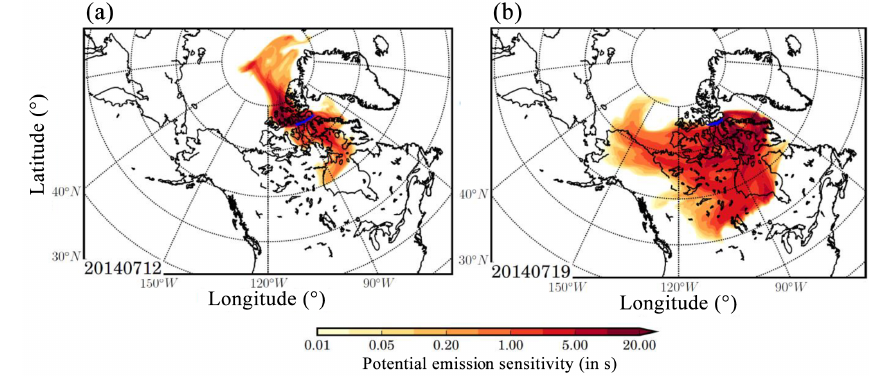
Figure 6. FLEXPART-ECMWF potential emissions sensitivity simulation plots for 4-day back trajectories for column from 0 to 1000m on (a) 12 July (20:40:00UTC) and (b) 19 July (17:00:00UTC) 2014. The colour bars indicate air mass residence time (s) before arriving at the aircraft location. The blue lines show Polar 6 aircraft routes.